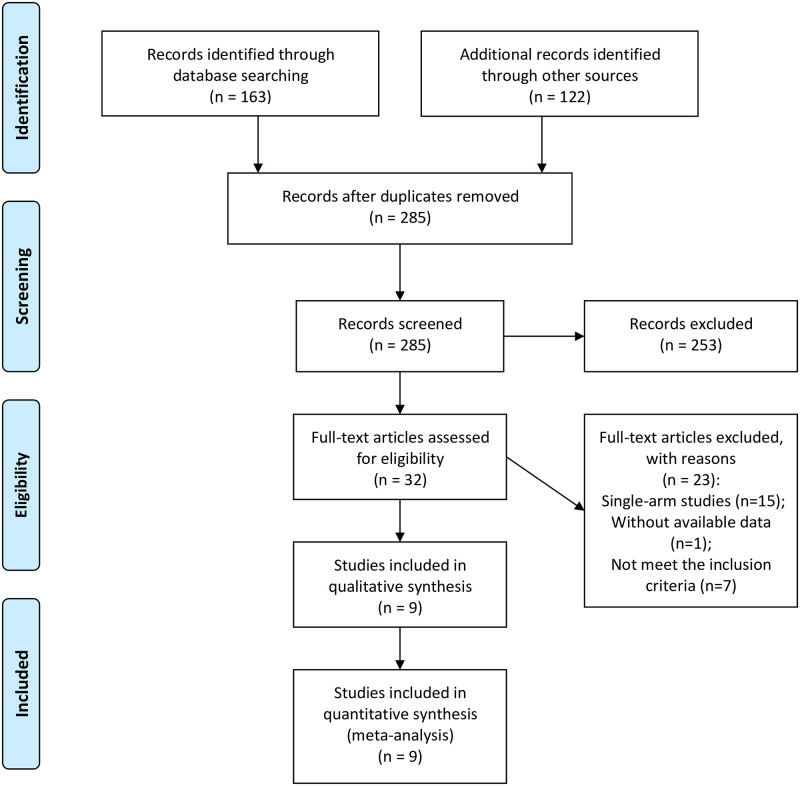
Flow diagram showing process of literature search and study selection.